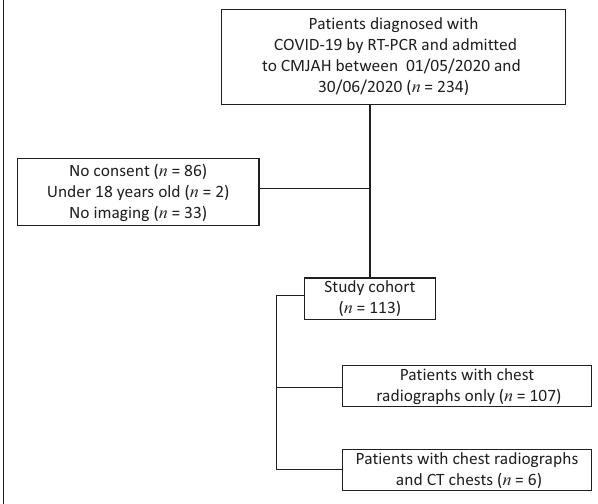
FIGURE 1: Cohort selection